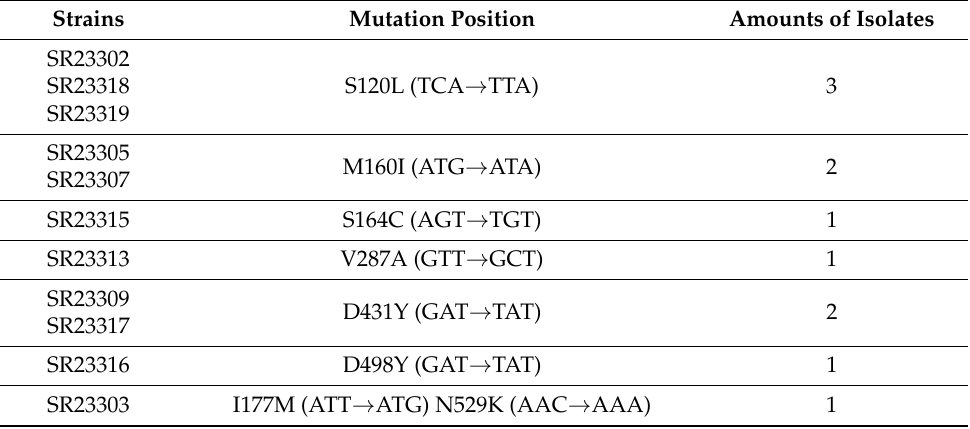
Table 3. Suppressor mutations that rescue the conditional lethality of ∆ ( lpxM clsA ) mapping to the msbA